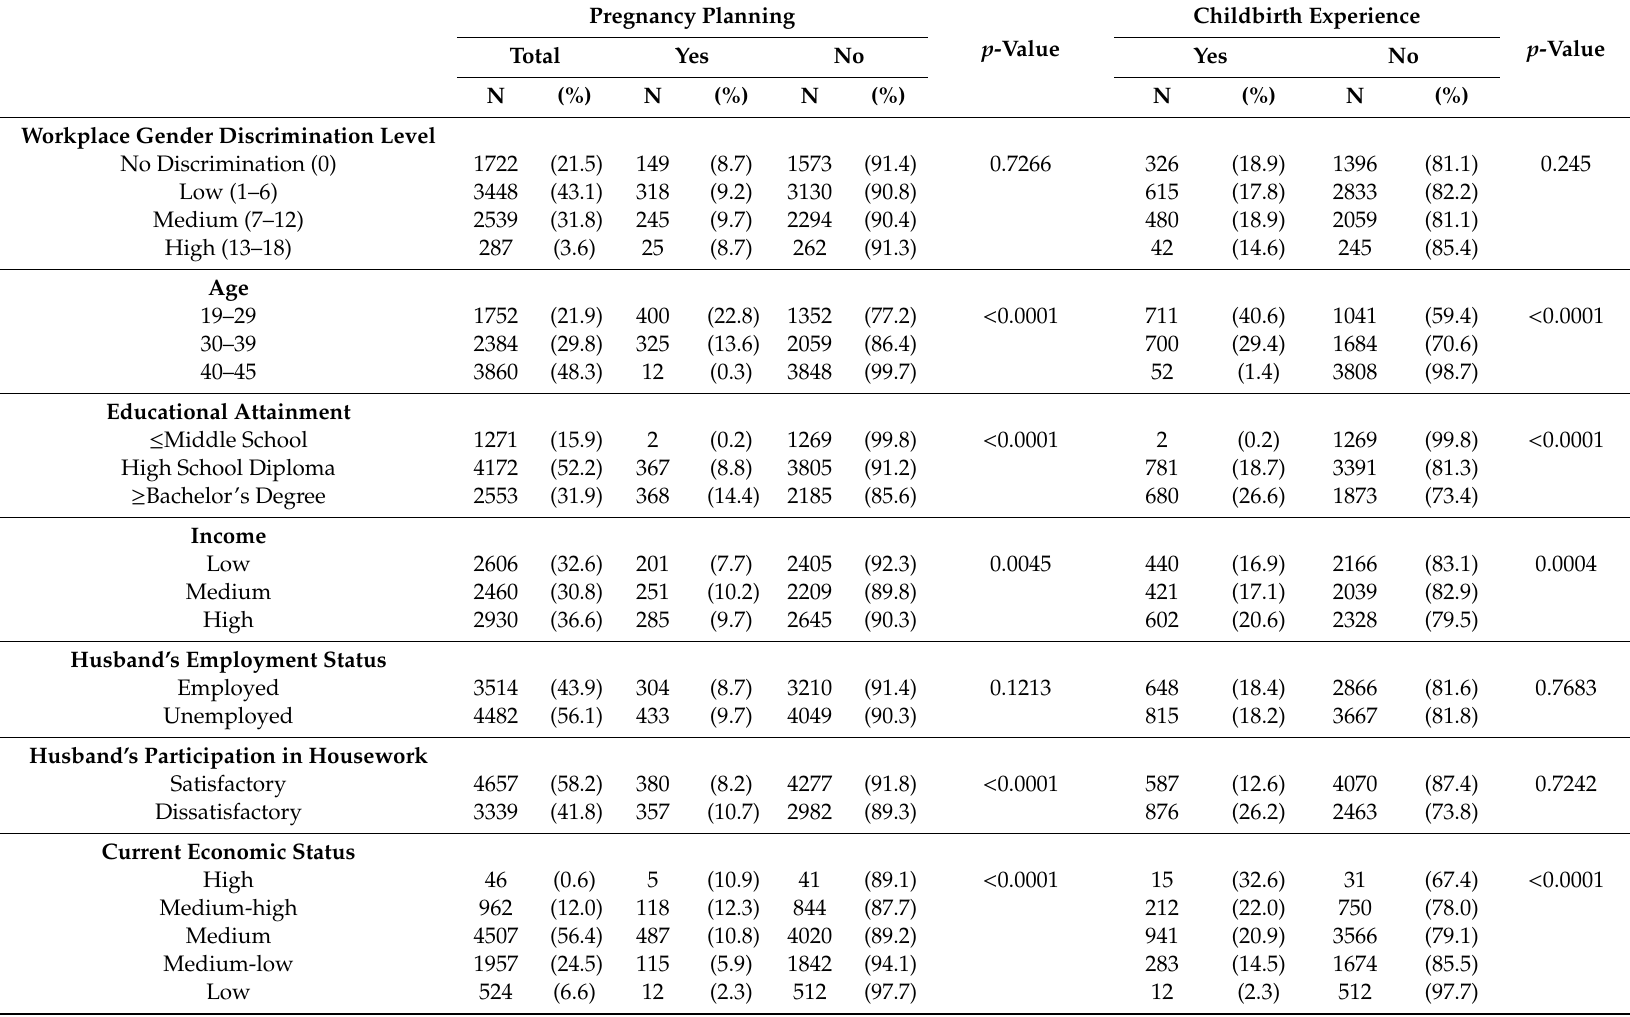
Table 2. General Characteristics of Study Observations